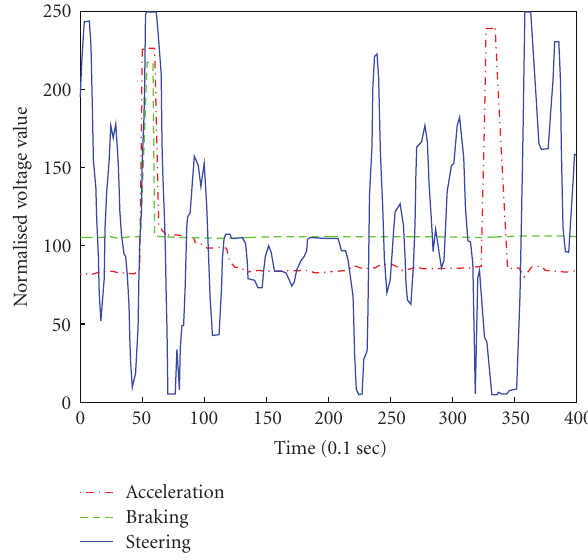
Figure 5: Human driving behavior